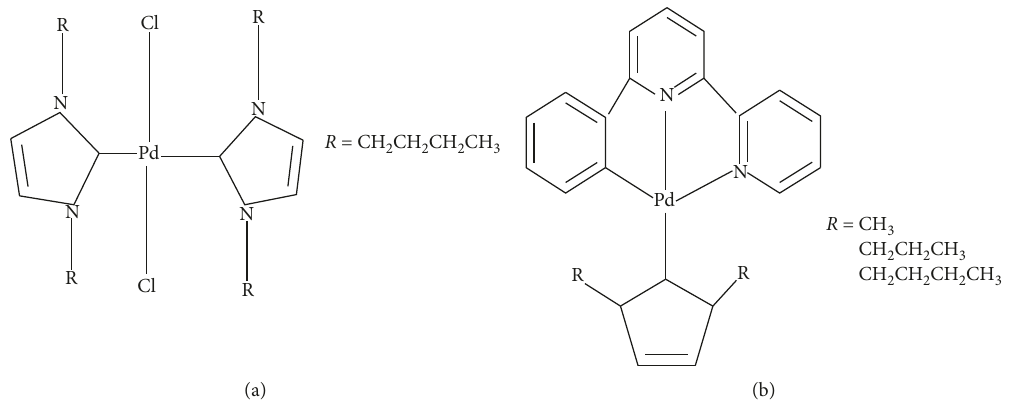
Figure 11: Palladium(II) NHC